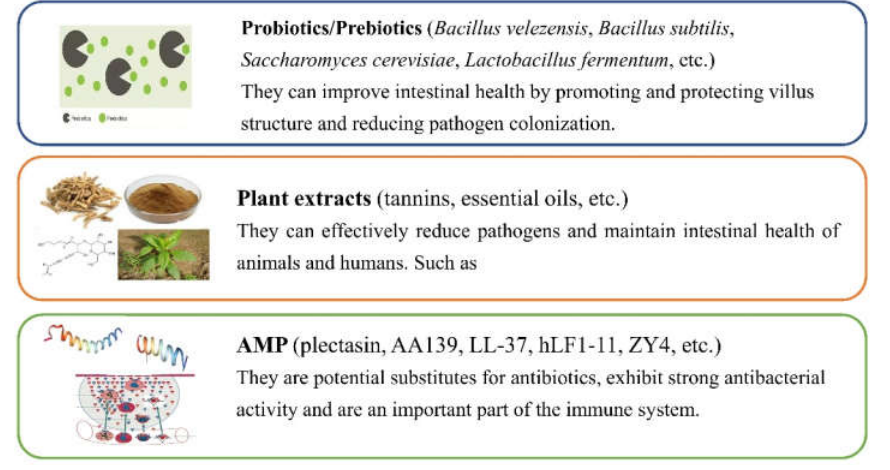
Figure 3. Alternatives to antibiotics to fight against AR E. coli .